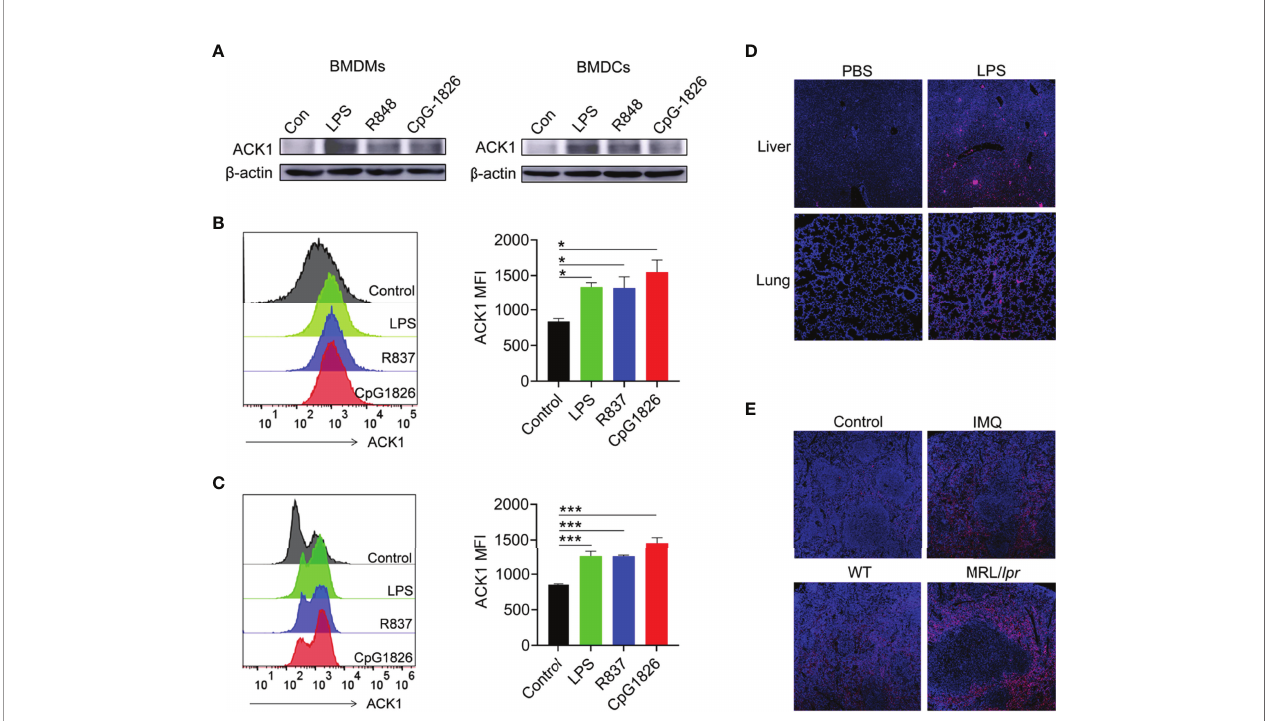
FIGURE 1 | TLRs induced ACK1 expression in vivo and in vitro . (A – C) Murine bone marrow cells-derived macrophages (BMDMs) and dendritic cells (BMDCs) were treated with LPS (100 ng/mL), R848 (1 m g/mL) and CpG-1826 (1 m M) for 24 hours. Western blot was performed to detect expression of ACK1 in BMDMs and BMDCs (A) . FACS analysis was performed to assess ACK1 expression in BMDMs (B) and BMDCs (C) at 24 hours. The data shown represent the means of three independent experiments and the error bars represent the S.E.M. (D) C57BL/6 mice were challenged by LPS (10 m g/g body weight) for 12 hours and then the expression of ACK1 in the lung and liver tissue sections was detected by using a confocal microscope. (E) Representative image of immuno fl uorescence of the ACK1 expression in the spleen pathological section from C57BL/6 mice treated-imiquimod for 10 weeks or spontaneous lupus MRL/ lpr mice (18-week-old). Blue represents DAPI; red represents ACK1. The data are shown as the means ± SEM (n = 6 mice/group) and are representative of three independent experiments. * p < 0.05, *** p < 0.001, as determined by ANOVA